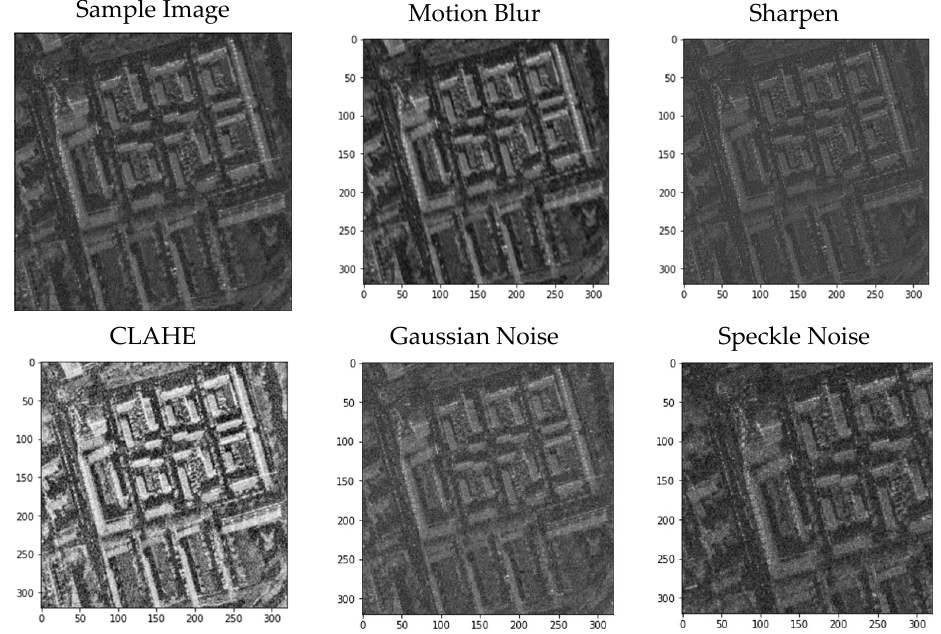
Figure 11. Summary of Pixel Transformations.